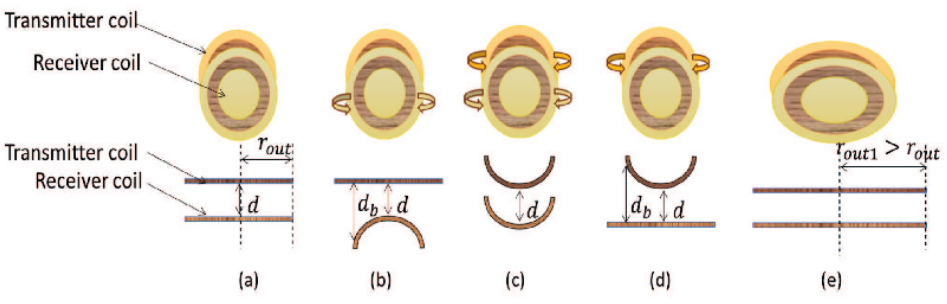
Figure 7. Flexible coil misalignment ( a ) ideal, ( b ) bended transmitter coil, ( c ) bending of both coils, ( d ) bended receiver coil, and ( e ) coil